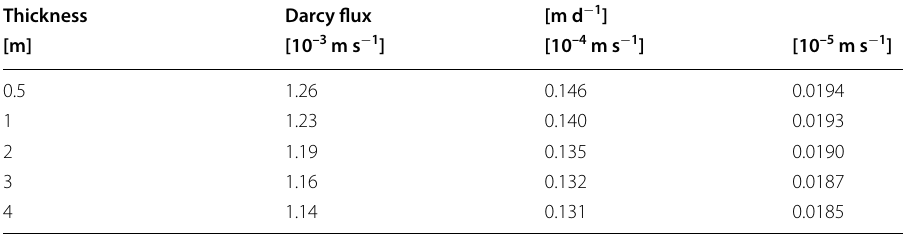
Table 4 Mean Darcy flux [m d − 1 ] for the whole fault area for the four given hydraulic conductivities